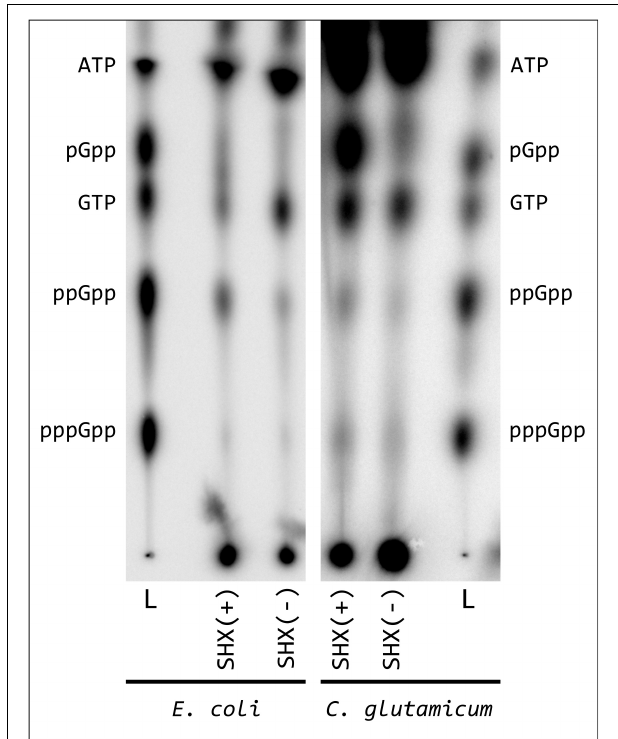
FIGURE 1 | Synthesis of hyperphosphorylated nucleotides in E. coli and C. glutamicum after SHX treatment. E. coli cells were labeled in MMM, C. glutamicum cells in CGXII medium (low P) for 3 h with 54 µ Ci/ml [ 32 P]orthophosphate. Subsequently the cultures were treated with 1 mg/L SHX and 0.5 mg/L L-valine, as described by Lemos et al. (2007) and further incubated for 30 min. For nucleotide extraction, the cell pellets from treated samples and the untreated controls were resuspended in 6 M formic acid, shock-frozen in liquid nitrogen and subjected to five freeze-thaw cycles. 1.5 µ L of the clarified supernatant were applied to PEI cellulose TLC-plates and developed in 1.5 M KH 2 PO 4 solution (pH 3.4). 32 P-labeled pGpp, ppGpp and pppGpp standards were prepared enzymatically by RelS catalyzed pyrophosphorylation of GMP, GDP, and GTP using [ γ - 32 P]ATP and applied together with [ γ - 32 P]ATP and [ α - 32